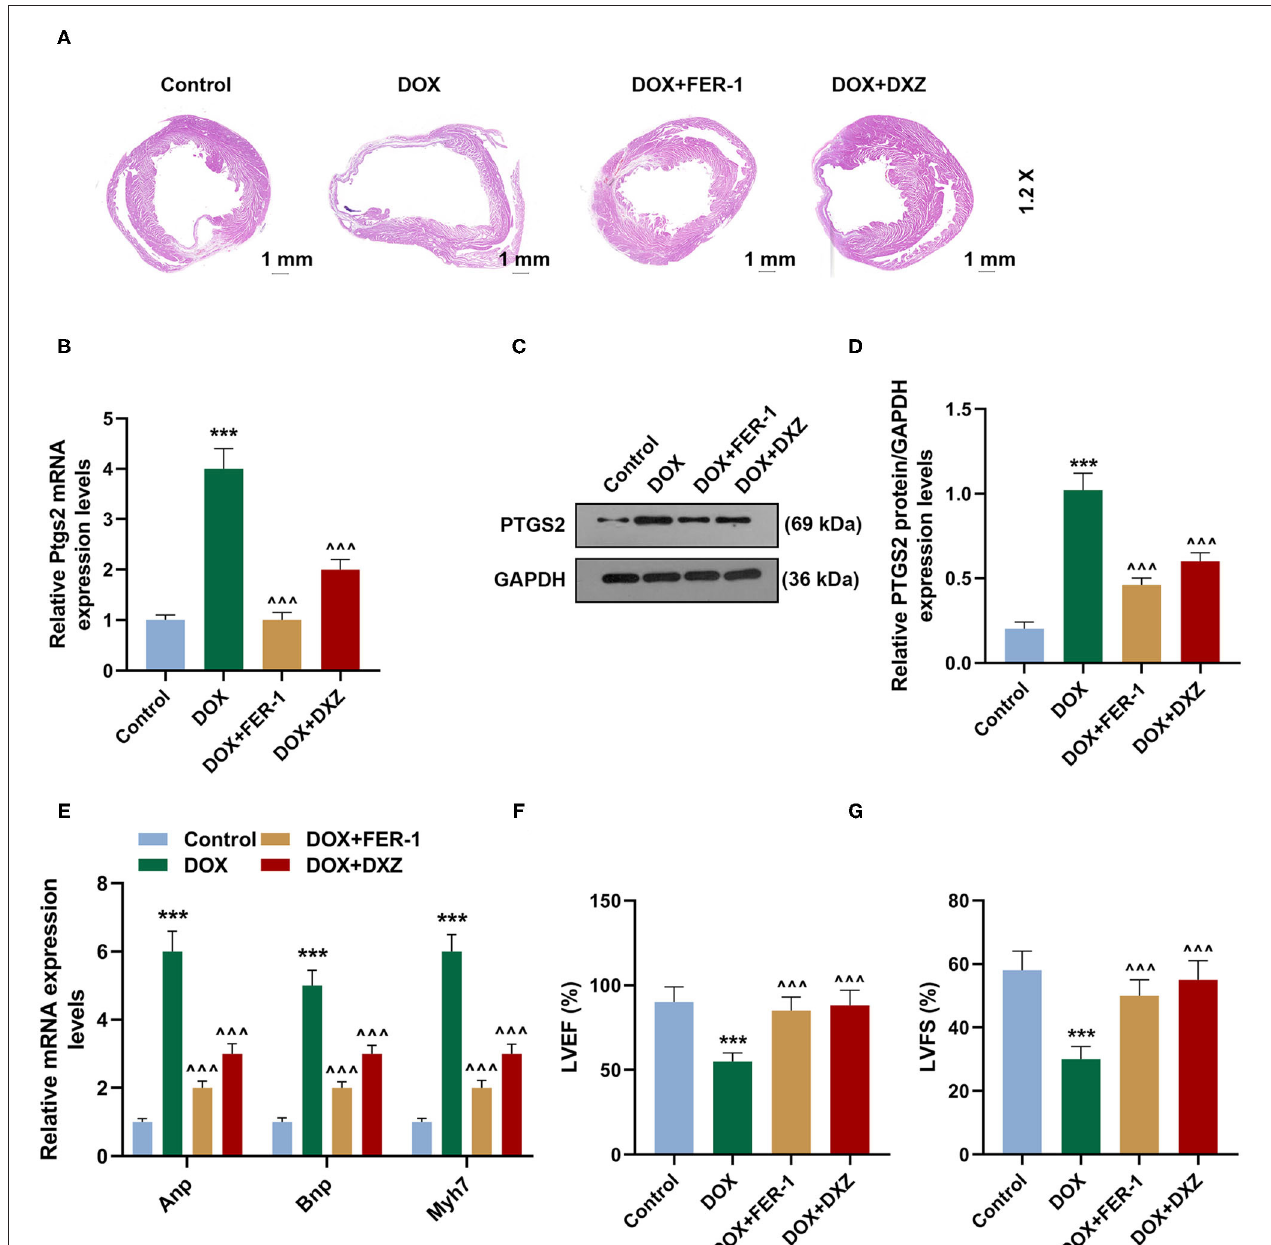
FIGURE 2 | Protective effects of FER-1 and DXZ on DOX-induced cardiomyopathy. (A) Representative images of HE staining of heart sections in rats from different groups. Magnification: × 1.2. Scale bar = 1mm with 10 rats in each group. (B–D) qRT-PCR and Western blot analysis show the mRNA and protein level of PTGS2, in heart tissues of rats with 10 rats in each group. Three mechanical duplications were performed in each sample. (E) qRT-PCR analysis show the mRNA expression of ANP, BNP and MYH7 in heart tissues of rats. (F,G) Echocardiographic analyses of cardiac function in control rats and rats treated by DOX with or without FER-1 or DXZ. Ten rats were included in each group. *** P < 0.001 vs. control. ∧∧∧ P < 0.001 vs. DOX. HE, hematoxylin-eosin; DXZ, dexazoxane; PTGS2, prostaglandin-endoperoxide synthase 2; ANP, natriuretic peptide A; BNP, natriuretic peptide B; MYH7, myosin heavy chain 7; qRT-PCR, quantitative real-time PCR; LVEF, left ventricular ejection fraction; LVFS, left ventricular fractional shortening.